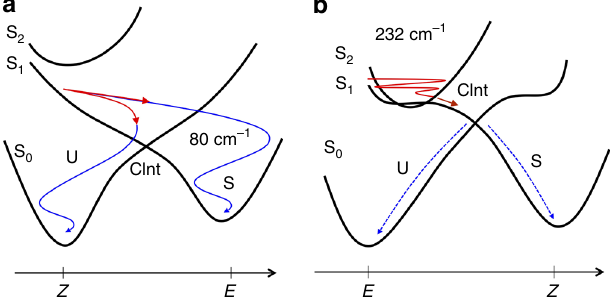
Fig. 5 Coherent and incoherent isomerization motions in the CInt vicinity. a , b Schematic representations of the S 0 , S 1 and S 2 PES ’ s (black solid curves) of Z- 1 and E- 2 , respectively, with the illustration of the vibrationally coherent (solid colored lines) or incoherent (dashed colored lines) reactive motions in the S 1 (in red) or S 0 (in blue) PES ’ s. Two decay channels corresponding respectively to successful (S) or aborted (U) isomerizations are